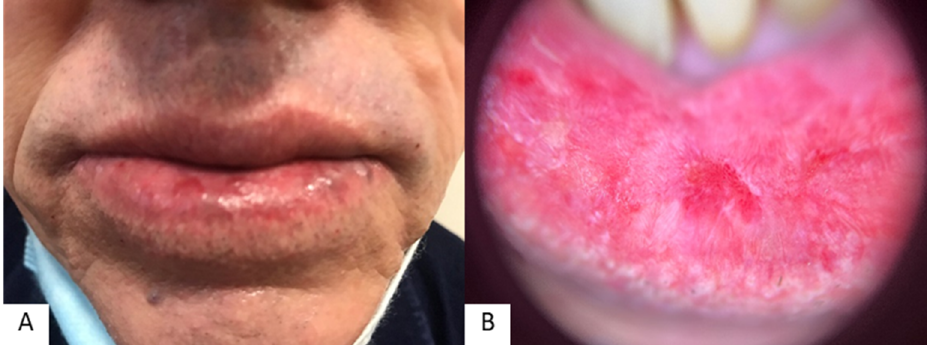
Figure 2. Actinic cheilitis: clinical finding ( A ) and dermoscopic finding ( B ); (mainly irreversible form).